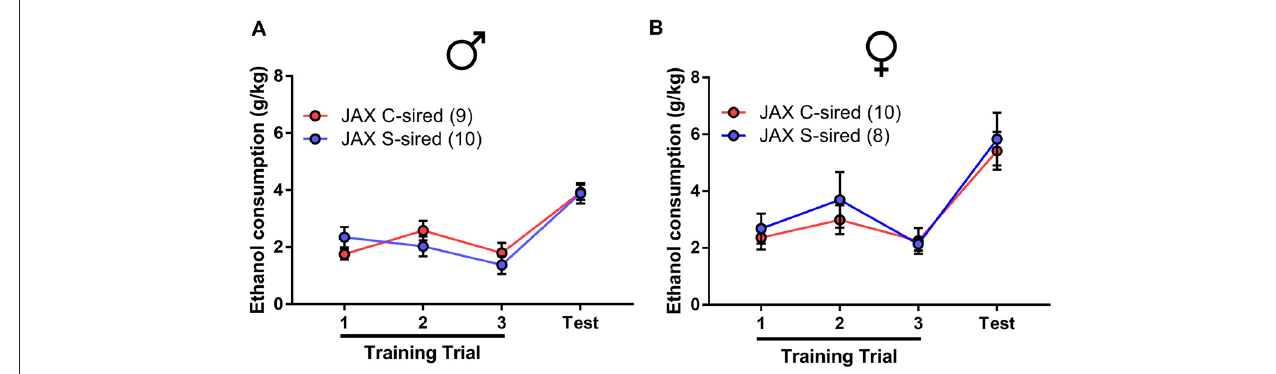
FIGURE 7 | No effect of JAX sire paternal stress on binge-like ethanol drinking. No effect of paternal stress with JAX sires on ethanol consumption of (A) males ( N = 9–10/group) or (B) females ( N = 10/group) in the drinking in the dark assay.